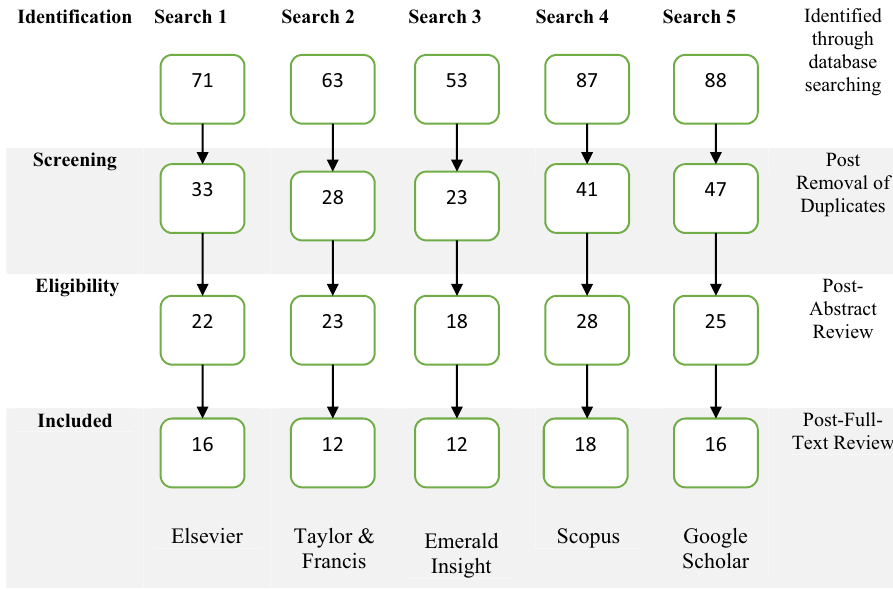
Figure 4: Overview of article identi fi cation, selection, and inclusion